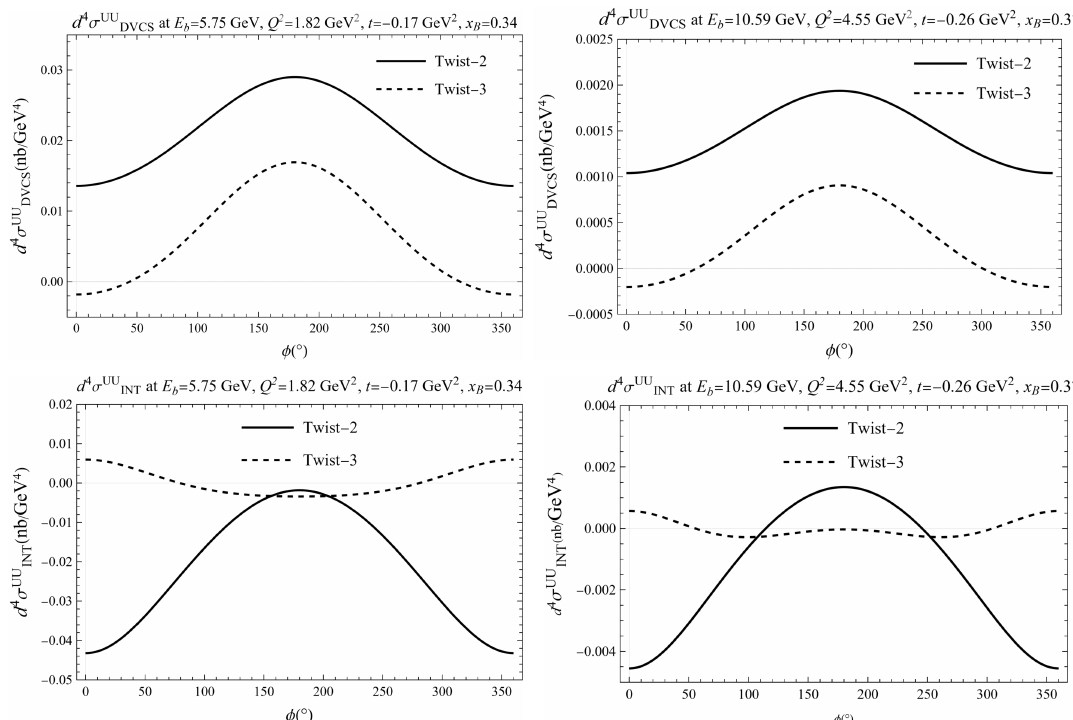
Figure 8 . A comparison of pure DVCS cross-sections (first row) and interference cross-sections (second row) at JLab 6 GeV (left) and 12 GeV (right) kinematics. The twist-two (solid lines) and twist-three (dashed lines) cross-sections are associated with the twist-two and twist-three CFFs, respectively. The twist-three pure DVCS cross-sections can be quite comparable to the twist-two ones, while the twist-three interference contributions are more